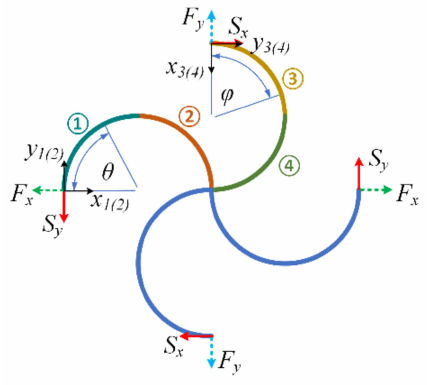
Figure 5. Unit cell under shear loading in the x–y